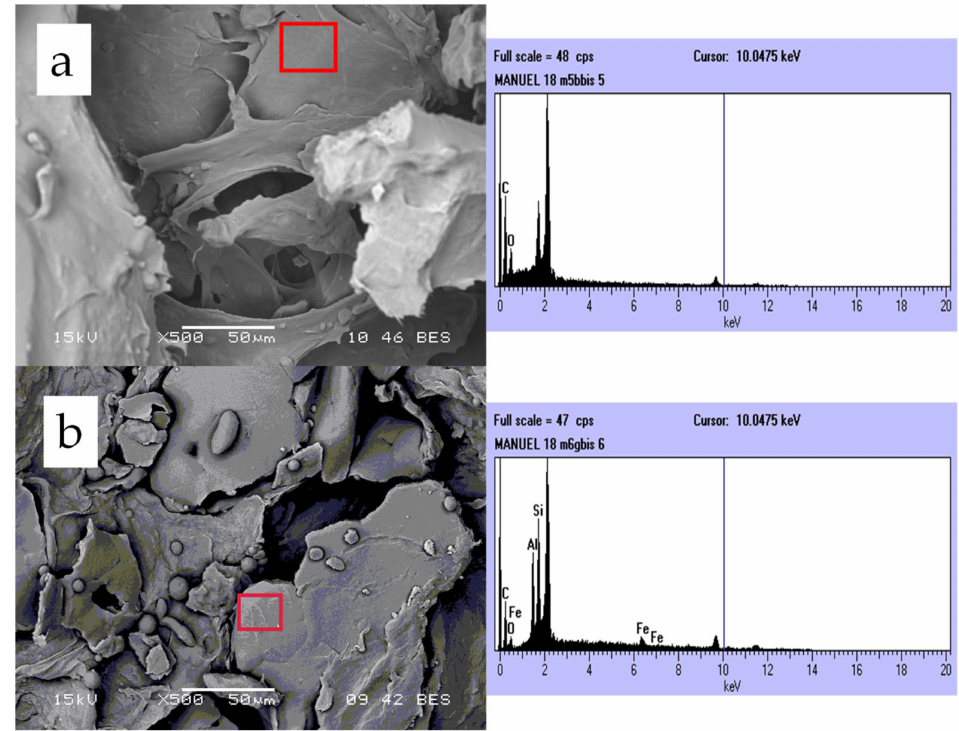
Figure A9. EDS for MCP sample before ( a ) and after ( b ) water